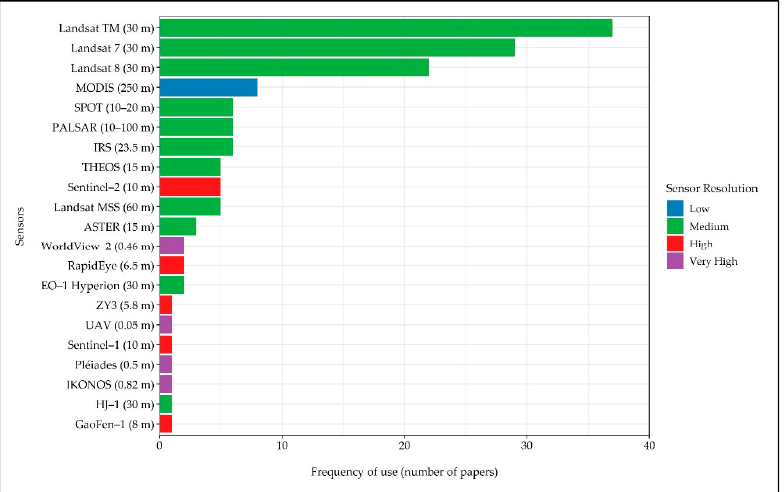
Figure 5. Distribution of used sensor types with its used frequency of use of data and respective spatial resolution classes from specific satellite missions.